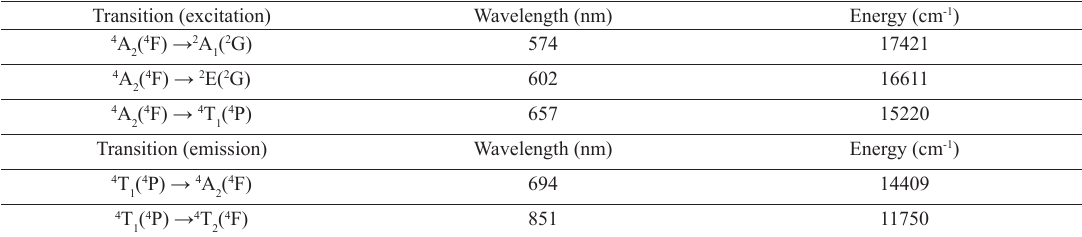
SnO :Co 2+ (0.1%). 2 4